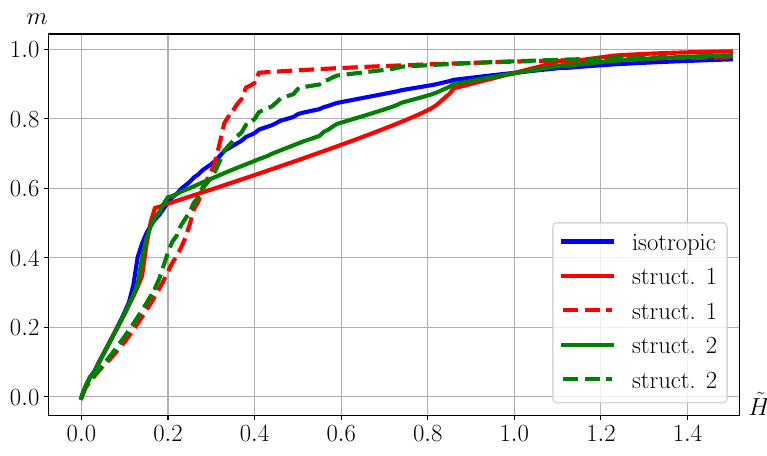
The solid lines in Figure 9 show the curves for such polycrystals when an external magnetic field is applied along the x axis. The difference is observed in a magnetic field from ˜ H 0 = 0.2 to ˜ H 0 = 1, when the main magnetization mechanism is the rotation of the magnetization vectors towards the applied magnetic field. The dashed lines show the magnetization curves for textured polycrystals when a magnetic field is applied at an angle of 45 ◦ to the x and y axes (for an isotropic polycrystal, the magnetization curve in this case completely coincided with the curve corresponding to the field acting along the x axis). For texture-oriented polycrystals, the magnetization curves differ depending on the direction of the applied magnetic field, since such polycrystals are anisotropic.